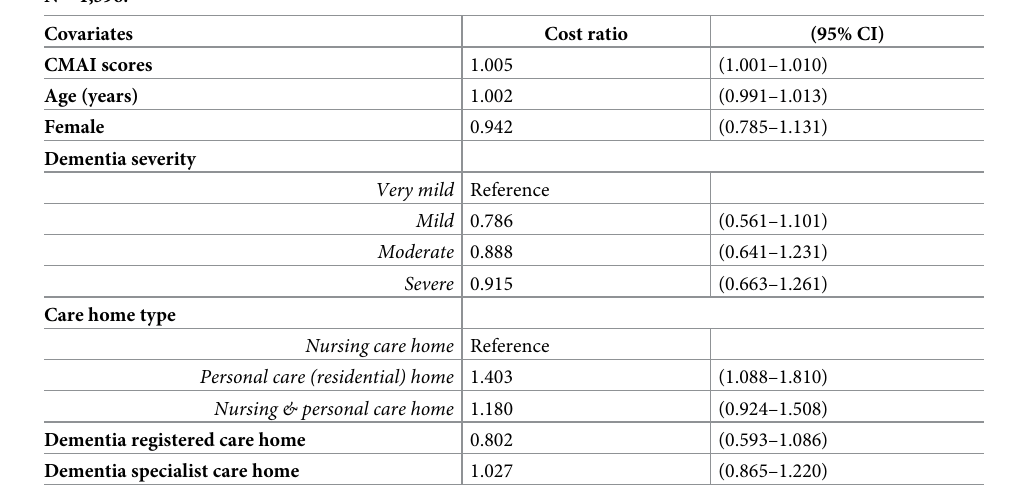
CMAI = Cohen-Mansfield Agitation Inventory; CI = confidence interval; N =